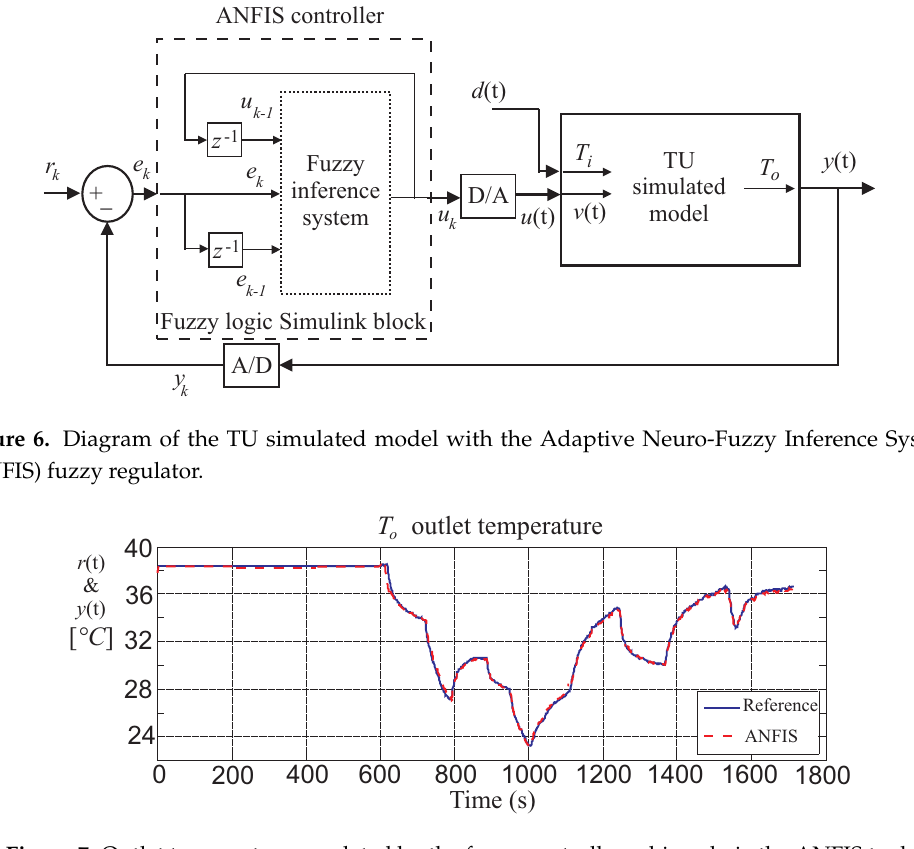
Figure 7. Outlet temperature regulated by the fuzzy controller achieved via the ANFIS tool.